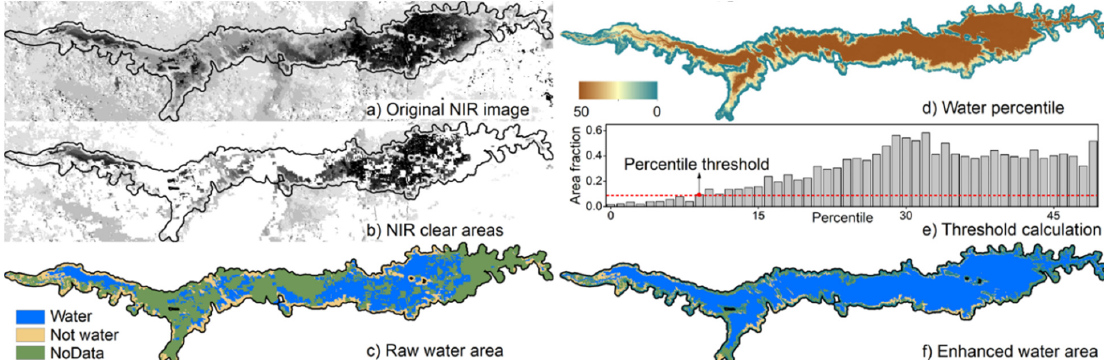
Figure 3. A demonstration of the water enhancement algorithm using the Cahora Bassa reservoir (Mozambique, Africa) on 1 January 2007, as an example: ( a ) original Near Infrared (NIR) image, ( b ) clear areas in NIR extruding the cloud contaminations, ( c ) water areas extracted from image ( b ), ( d ) water occurrence (percentile) image, ( e ) percentile threshold used for enhancement, and ( f ) water areas after enhancement.